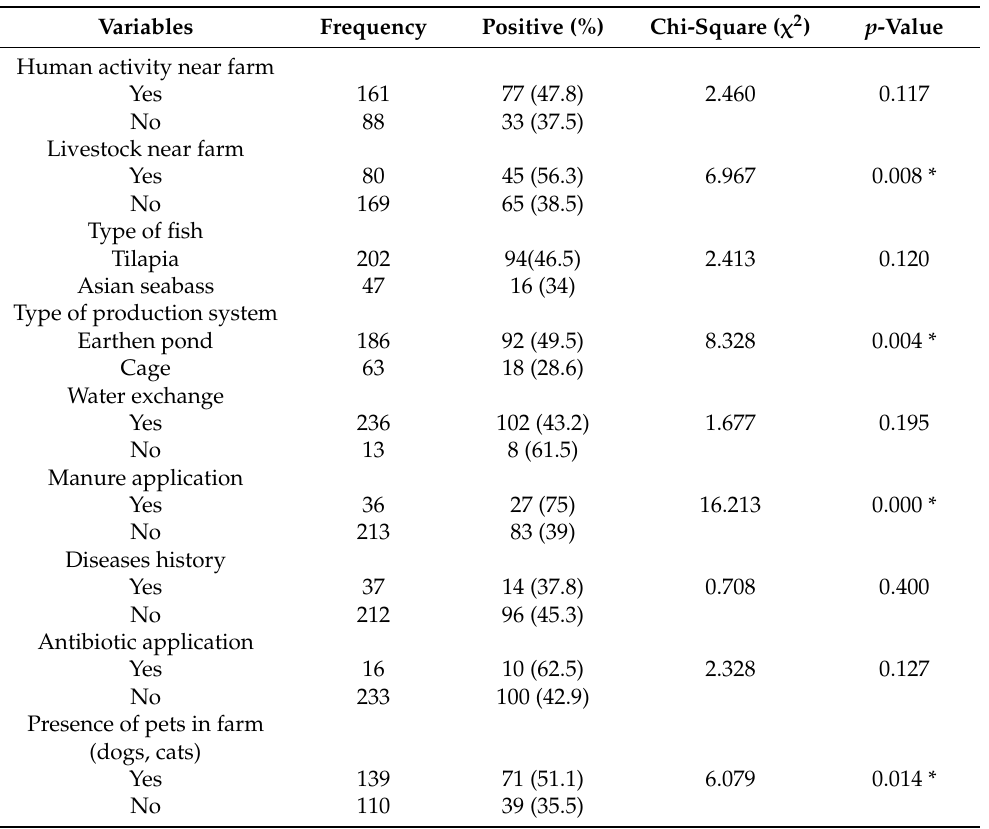
Table 1. Univariable analysis for risk factors associated with the growth of MDR E. coli in the aquaculture production systems ( n = 32) on the west coast of peninsular